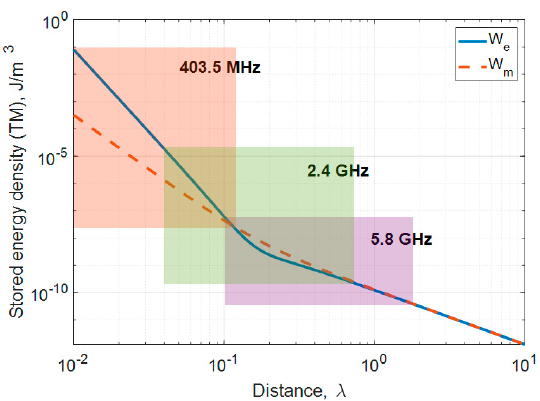
Figure 5. Stored electric and magnetic energy densities of a small dipole antenna.